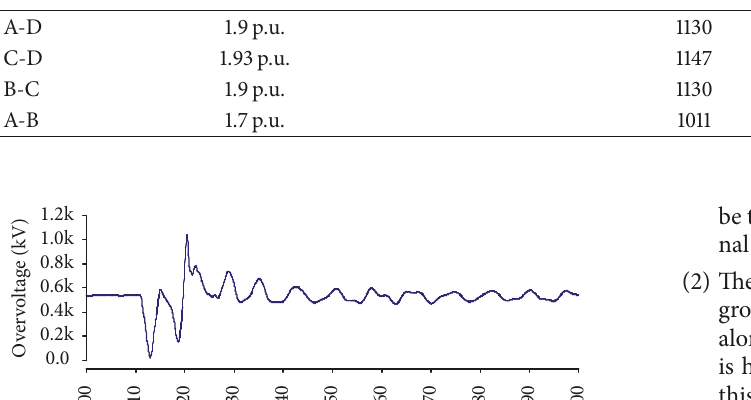
Table 3: Required values of air gaps under switch impulse overvoltage for a 4-terminal MMC-HVDC project. Lines Switching overvoltage level (p.u.)